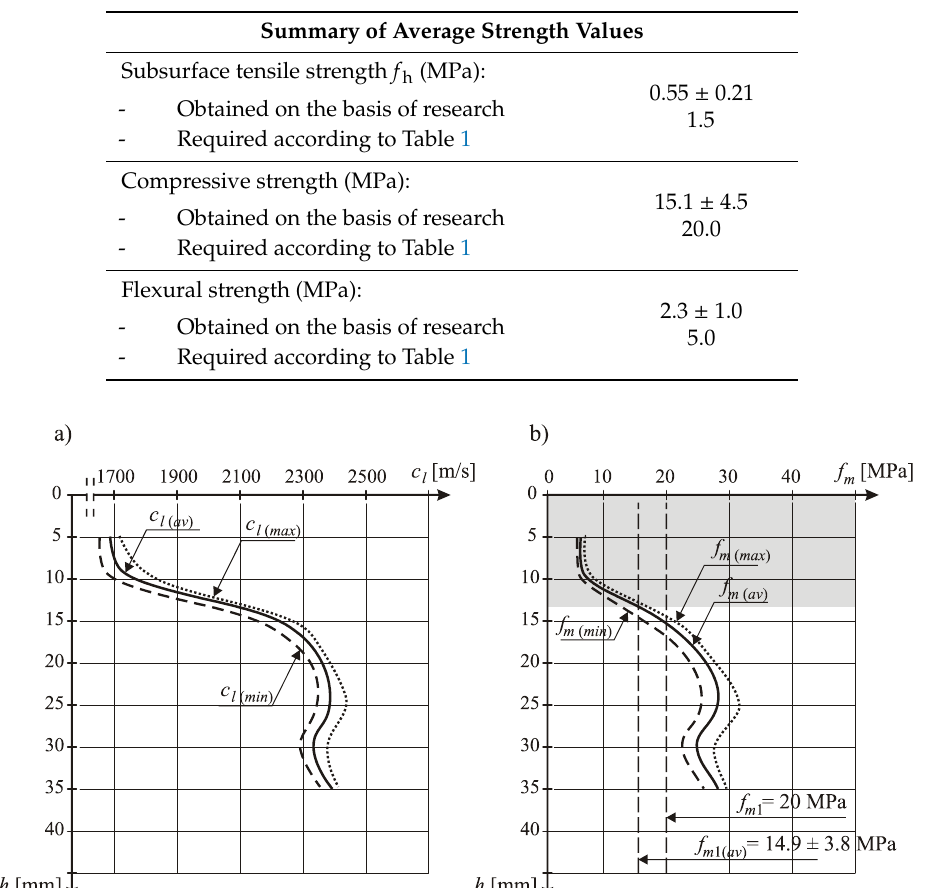
Figure 8. An example of the course: ( a ) the longitudinal velocity of the ultrasonic wave c l along the thickness h and ( b ) the compressive strength f m of the cement mortar along thickness h.